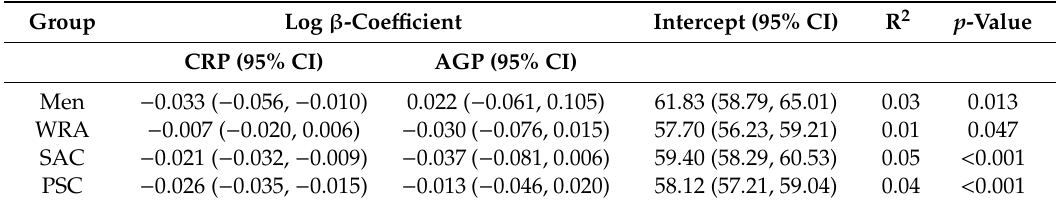
Table 4. Regression outputs of SZC versus inflammatory markers for di ff erent demographic groups.